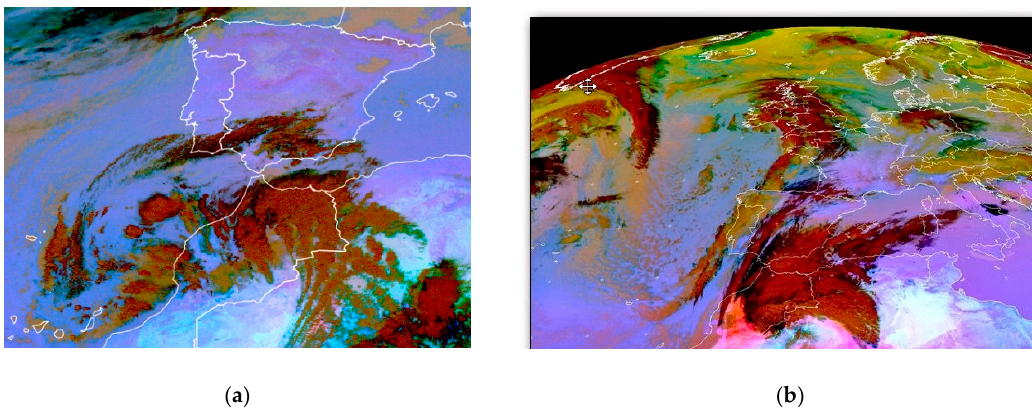
Figure 4. RGB “dust” composition. Second Generation Meteosat, EUMETSAT. The area embossed in red shows the suspended dust located on the African continent and the south of the Iberian Peninsula, associated with a storm. ( a ) Saharan dust outbreaks on January 31, 2018; ( b ) Saharan dust outbreaks on February 17, 2014.